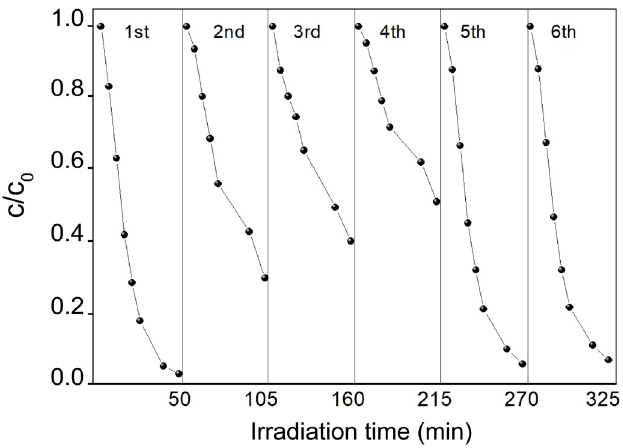
Figure 12. Recyclability test of fabric S4, after the regeneration procedure, in five subsequent photocatalytic MB degradation experiments.